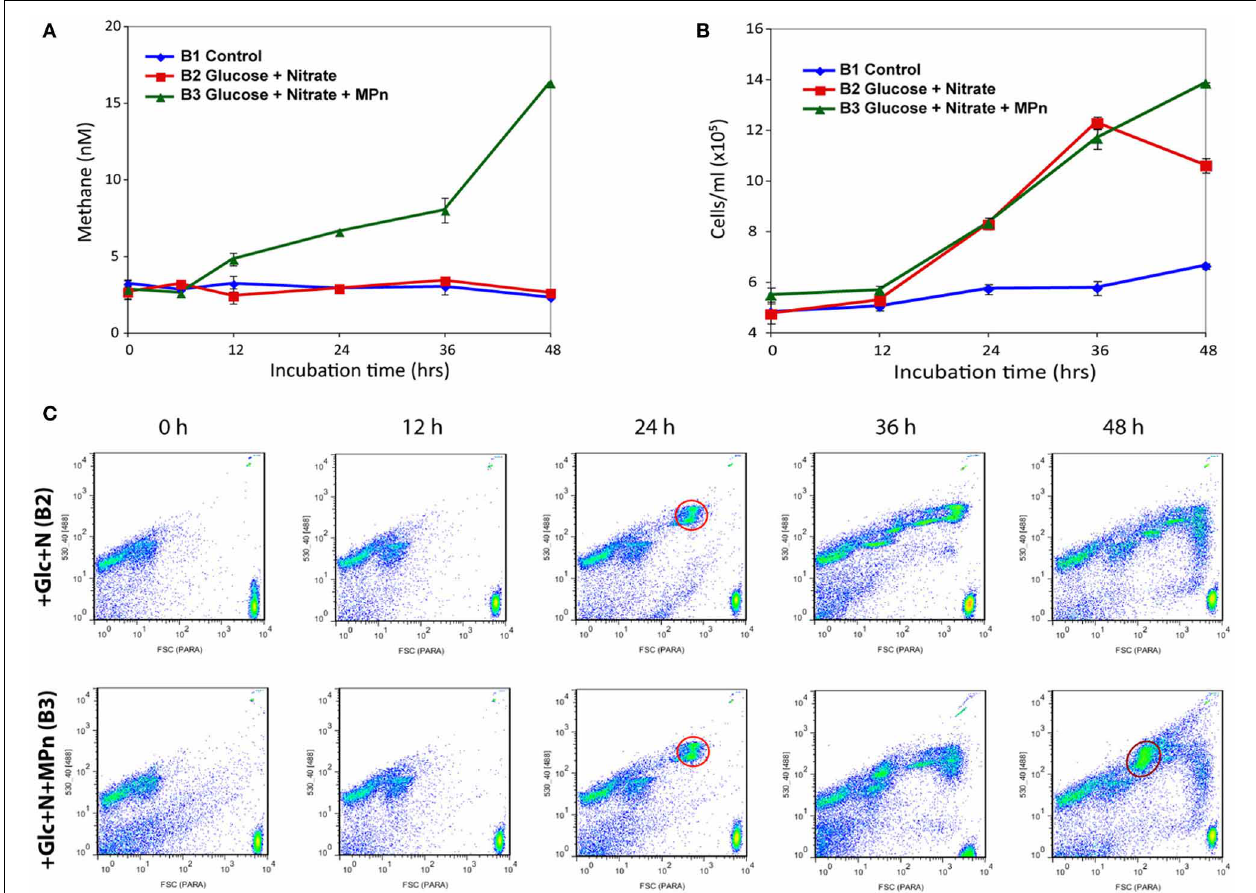
FIGURE 2 | CH 4 accumulation and cell number dynamics during 48h microcosm incubations. Three microcosms containing 20 L of sea